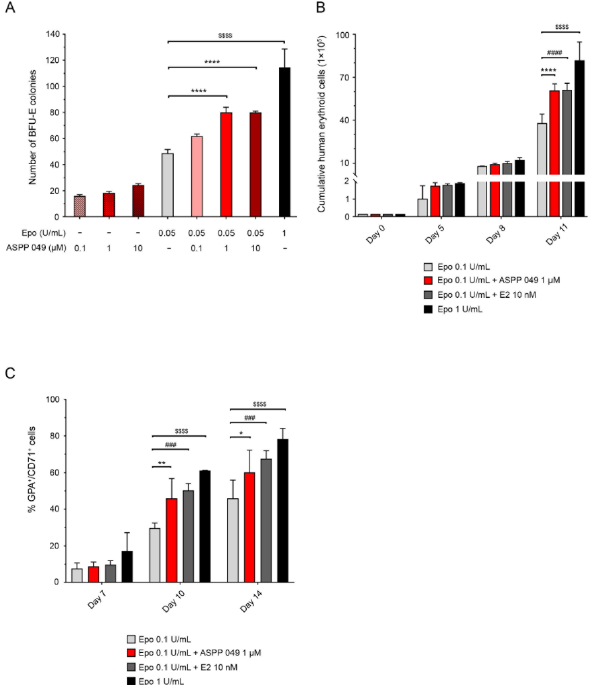
Figure 3. ASPP 049 and E2 increased erythropoiesis of human HSC ‐ derived erythroblasts. ( A ) Human CD34 + HSCs plated in MethoCult H4236 were treated with various concentrations of ASPP 049 in the presence of 0.05 U/mL of Epo; 1 U/mL Epo was used as a positive control. Numbers of BFU ‐ Es were scored on day 14 according to the manufacturer’s recommendations. ( B ) ASPP 049 and E2 increased human erythroid cell survival. CD34 + HSCs plated in a human erythroid culture medium were treated with 1 μ M ASPP 049 and 10 nM E2 in the presence of 0.1 U/mL of Epo for the indicated times; 1 U/mL Epo was used as a positive control. HSC ‐ derived erythroid cell survival was observed by trypan blue exclusion assay. ( C ) ASPP 049 and E2 increased human immature erythrocyte populations. CD34 + HSCs plated in a human erythroid culture medium were treated with 1 μ M ASPP 049 and 10 nM E2 in the presence of 0.1 U/mL of Epo for the indicated times; 1 U/mL Epo was used as a positive control. Expression of immature erythrocyte markers (GPA + CD71 + ) was detected by flow cytometry analysis. All data are expressed as mean ± SEM ( n = 3). * p < 0.05 and ** p < 0.01, **** p < 0.0001. ASPP 049 compared with vehicle control treatments (ANOVA); ### p < 0.001 and #### p < 0.0001, E2 compared with vehicle treatments (ANOVA); $$$$ p < 0.0001, 1 U/mL compared with ve ‐ hicle control treatment (ANOVA). BFU ‐ Es, burst ‐ forming unit ‐ erythroid cells; E2, 17 β‐ estradiol; Epo, erythropoietin; HSCs, hematopoietic stem cells.